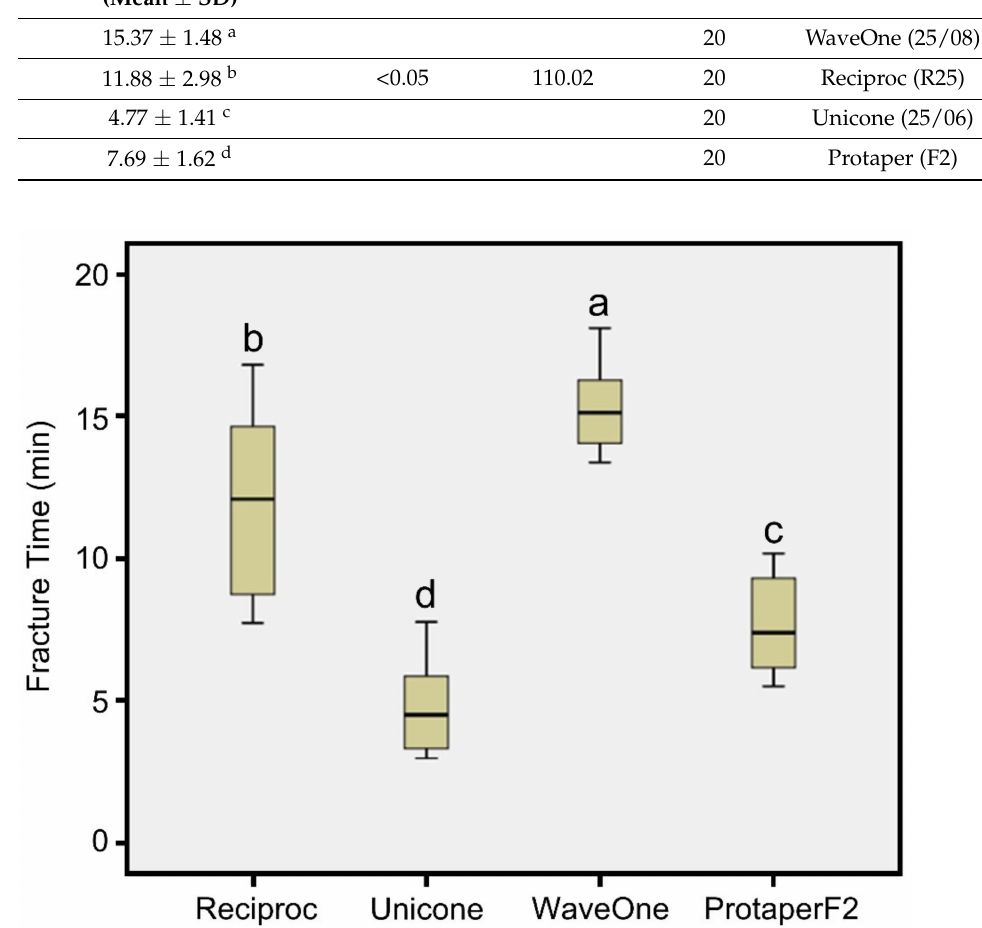
Figure 2. Box plot comparing the fracture time of the four endodontic rotary files. The box median is shown as a line, as are the upper and lower quartiles. Values indicated by different letters are statistically different from each other ( p <